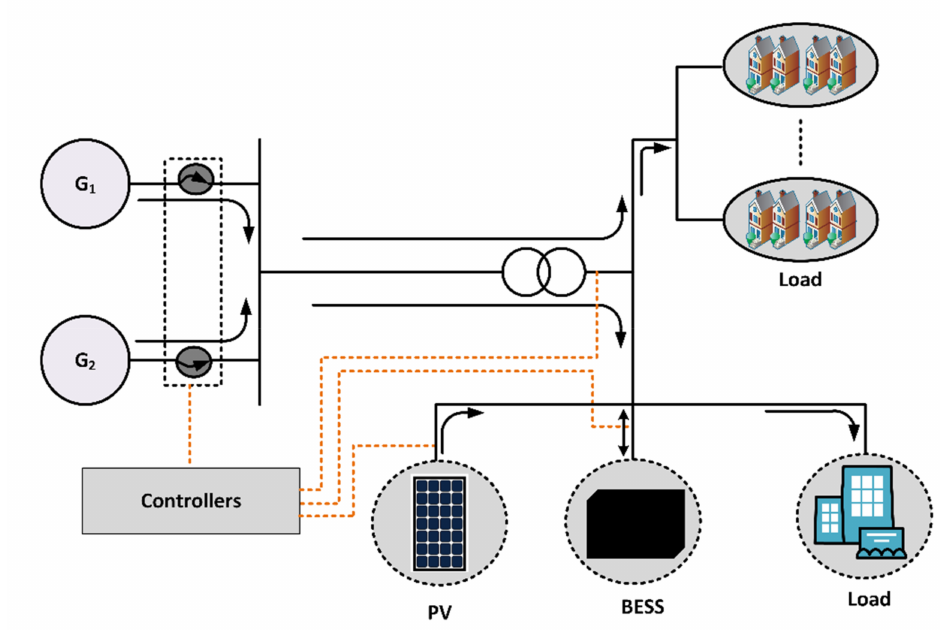
Figure 6. A schematic diagram of the developed IMG